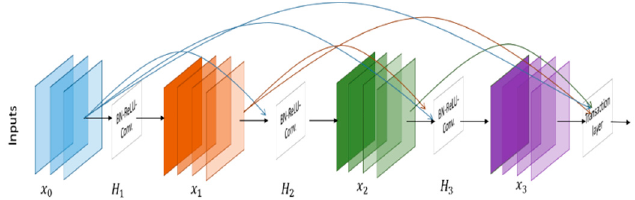
Figure 18. A 4-layer Dense block with a growth rate of 𝑘 = 3 .